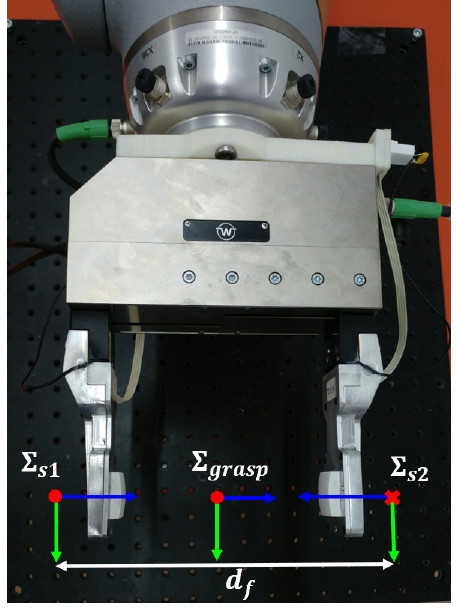
Figure 14. Definition of the grasp frame Σ grasp